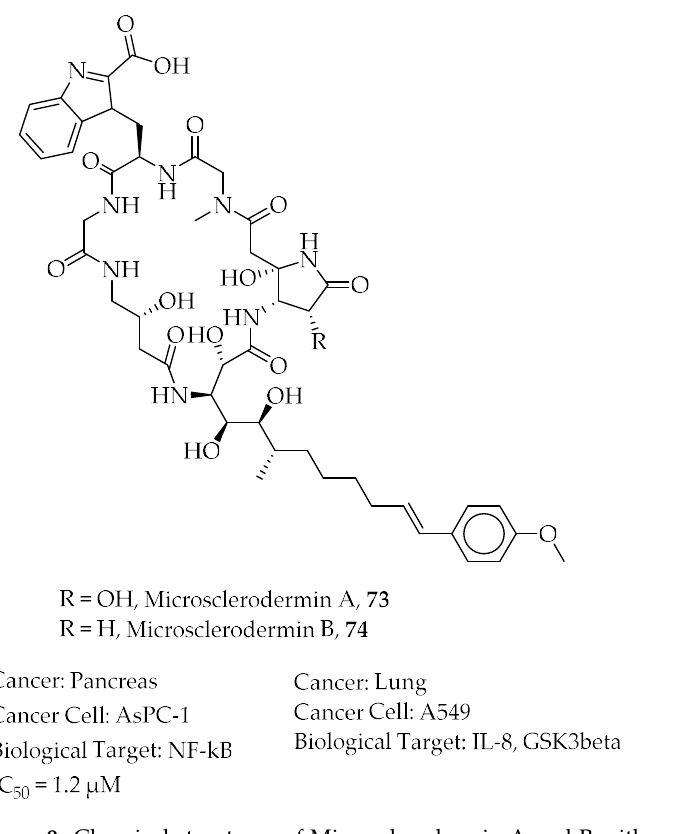
Figure 9. Chemical structures of Microsclerodermin A and B with a summary of their biological activity towards selected cancer targets.